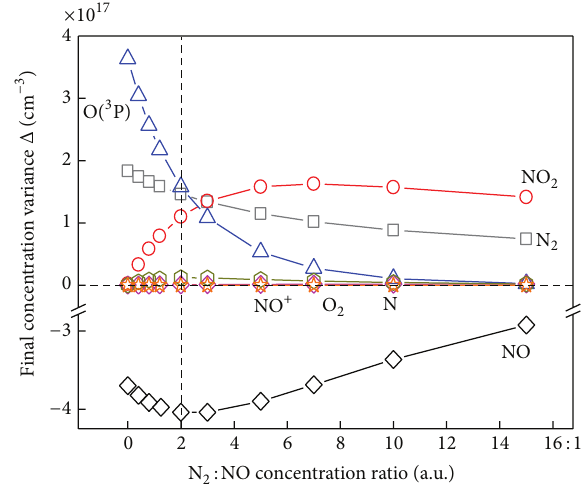
Figure 12: The final concentration variance Δ of the main species under different N 2 /NO